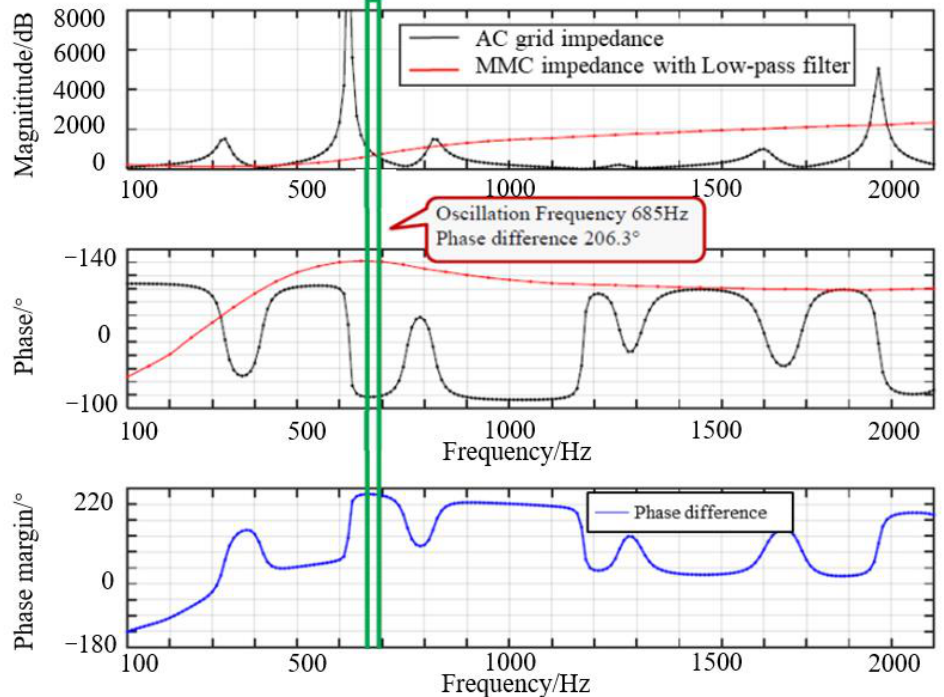
Figure 12. Impedance characteristic of system with low-pass filter.